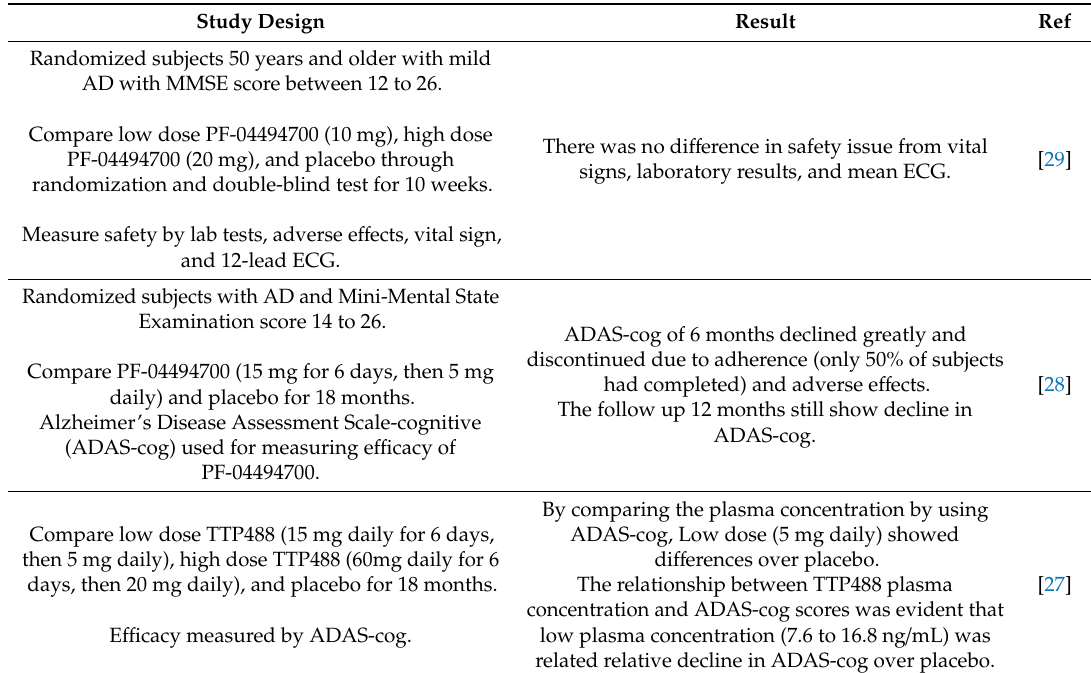
Table 1. Studies evaluating Azeliragon as a RAGE